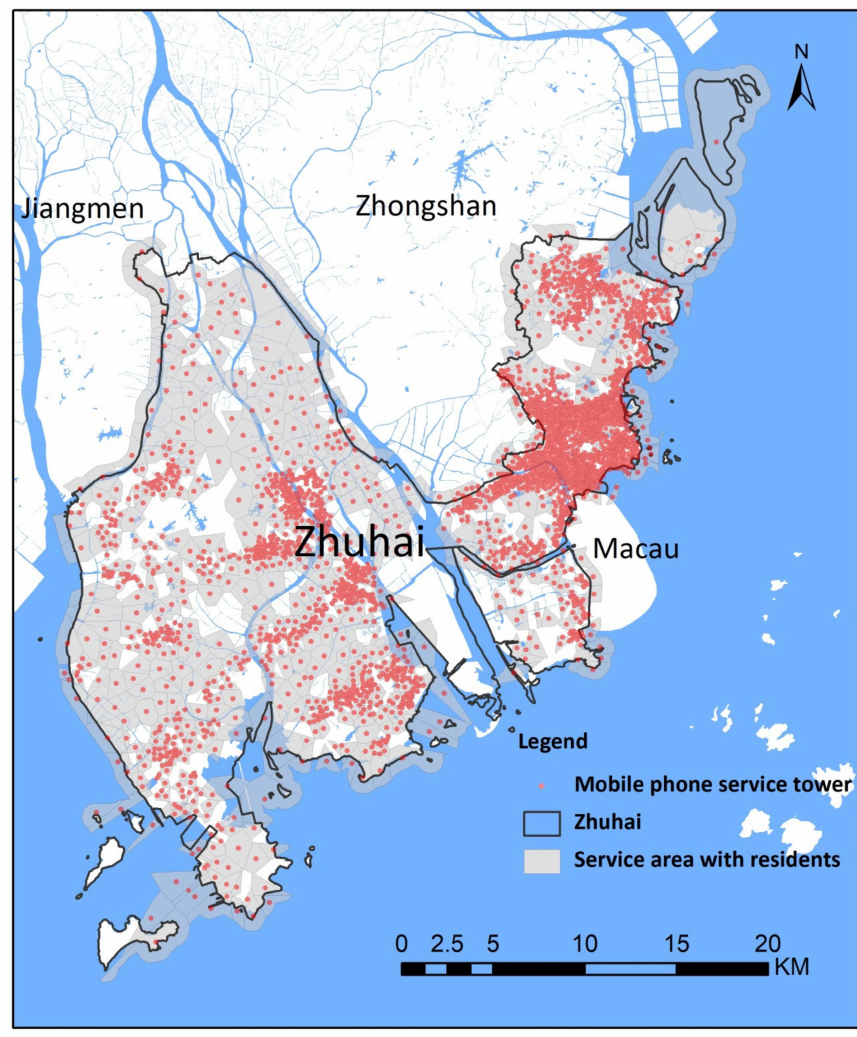
Figure 1. Study area and mobile phone service